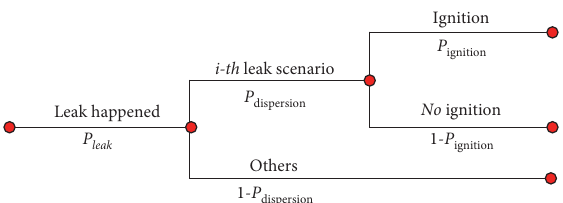
Figure 28: Event tree of the gas